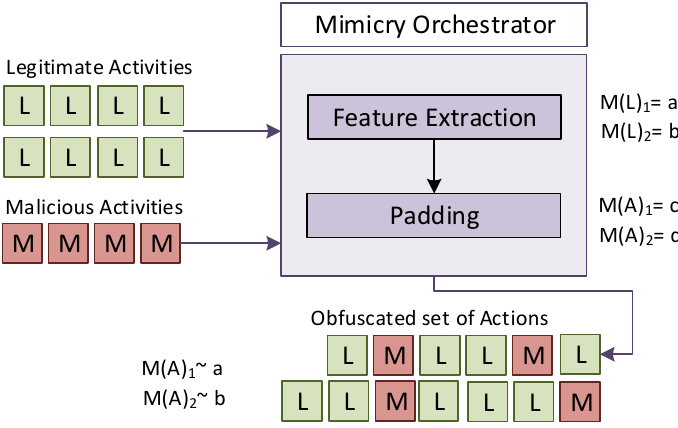
Figure 1. Orchestration of locality-based mimicry.